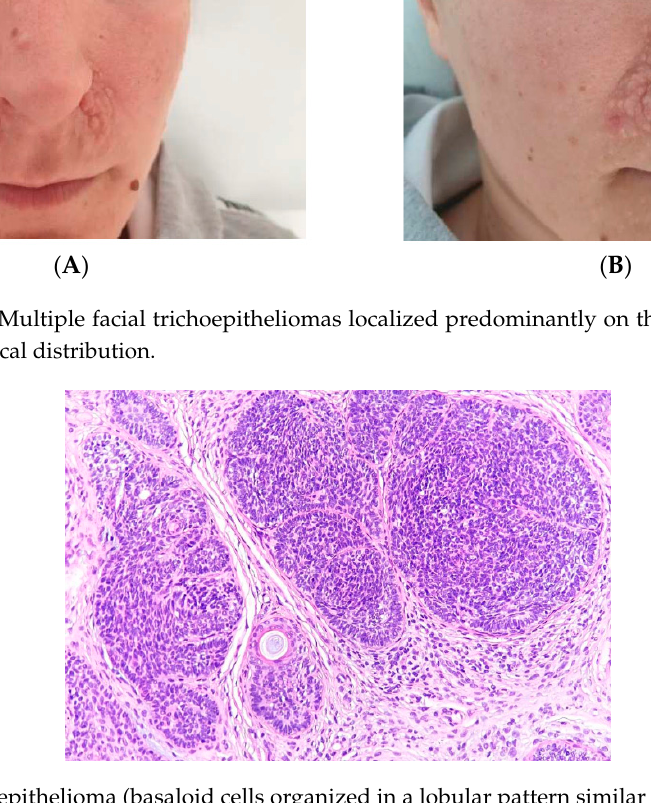
Figure 3. Scalp trichoepitheliomas. Figure 4. Bilateral trichoepitheliomas on the lateral aspect of the 5th digits. Case 3: A 45-year-old female patient, the mother of the previous patient (Figure 5), presented with a brown-yellowish nodule located on the scalp as well as a few skin-colored, millimetrical papules on the nasolabial folds with onset at the age of 13 years. The physical examination revealed a firm, brown-yellowish, well-demarcated, asymptomatic nodule on the scalp (Figure 6), as well as few skin-colored, asymptomatic papules, 3–5 mm in diameter located on the nasolabial folds. The biopsies taken confirmed the diagnosis of cylindroma on the scalp and trichoepithelioma on the face. The cylindroma was removed by surgical excision, whereas the facial trichoepitheliomas were treated by electrosurgery.